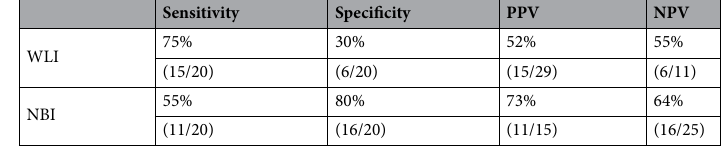
Table 3. Detailed results of the AI-based diagnosis for each case. PPV: positive predictive value, NPV: negative predictive value, AI: artificial intelligence, WLI: white light imaging, NBI: narrow-band imaging.